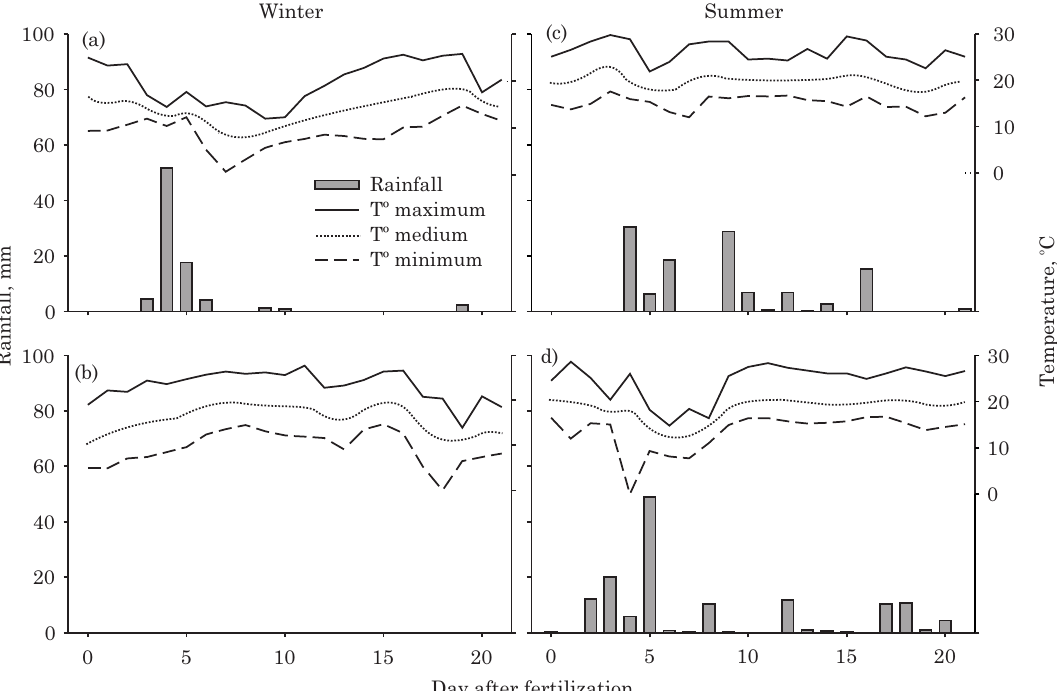
Figure 1. Rainfall, air temperature (maximum, medium and minimum) in the experiment with wheat (a, b) and maize (c, d), in two growing seasons (2009 and 2010) in the south-central region of Paraná.